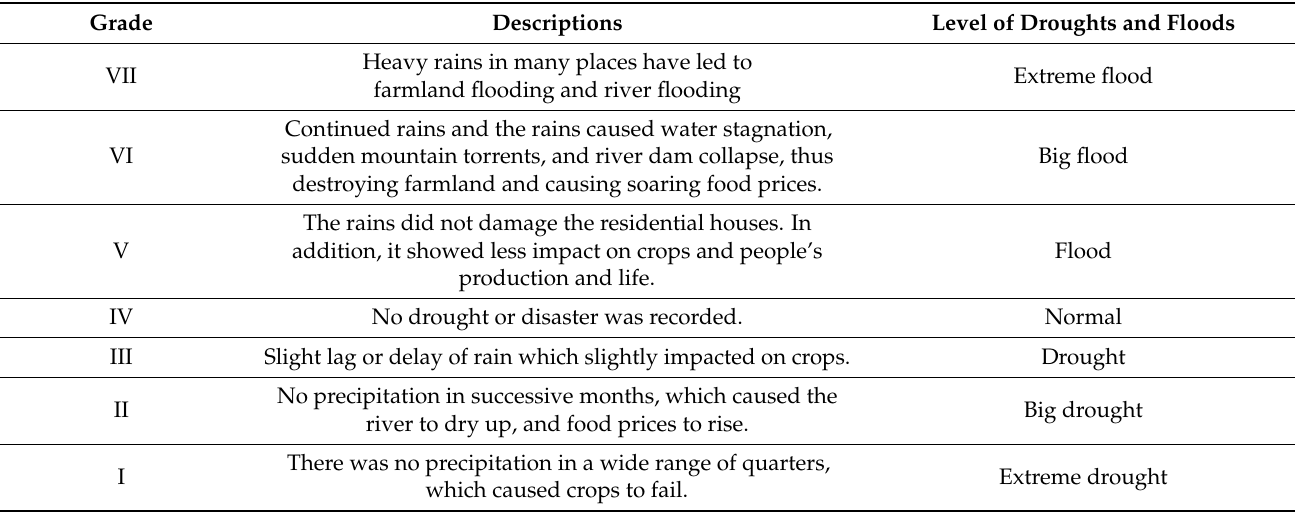
Table 1. Classification standard of droughts and